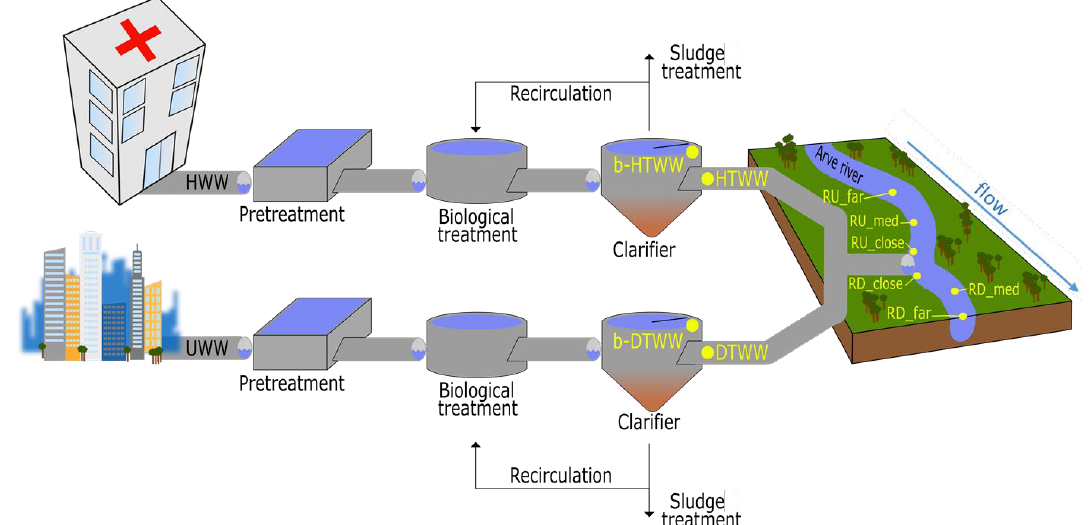
Figure 1. Illustration of the SIPIBEL experimental site (wastewater treatment plant of Bellecombe, Scientrier, Haute-Savoie, France). The hospital (HWW) and domestic wastewater (UWW) treatment files are shown. Treated waters (TWW) from the HTWW and DTWW clarifiers join into a single pipe prior to being delivered into the Arve river. Sampling points are represented by yellow dots. Biofilms (b) on blueschist rocks positioned 5 cm below the waterline were sampled from the hospital (b-HTWW) and domestic (b-DTWW) treatment files of the clarifiers. Treated wastewaters (HTWW and DTWW) were sampled at the outlets of the clarifiers. Blueschist biofilms (b-) and Arve River waters were sampled upstream and downstream of the outlet of the WWTP at (i) a distance of 8 km (RU_far and RD_far), (ii) 500 m (RU_med and RD_med), and (iii) 10 m (RU_close and RD_close).